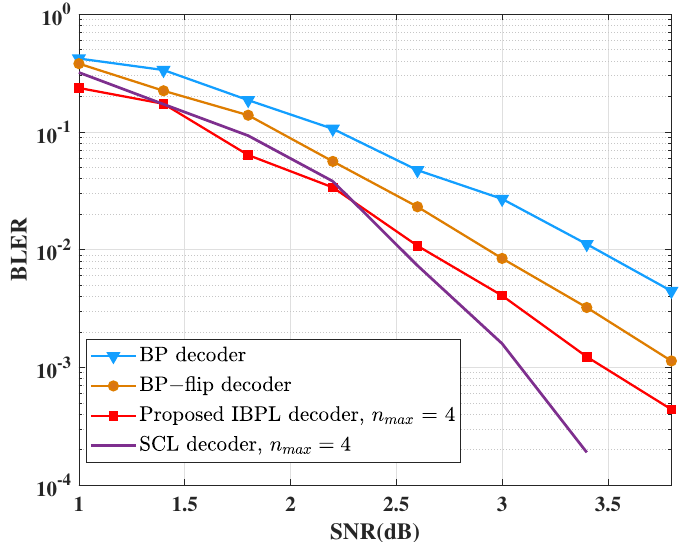
Figure 8. BLER performance comparison among IBPL decoder, BP decoder, BP-flip decoder, and SCL decoder when code length is 128 bits, code rate is 1/2, and n max =